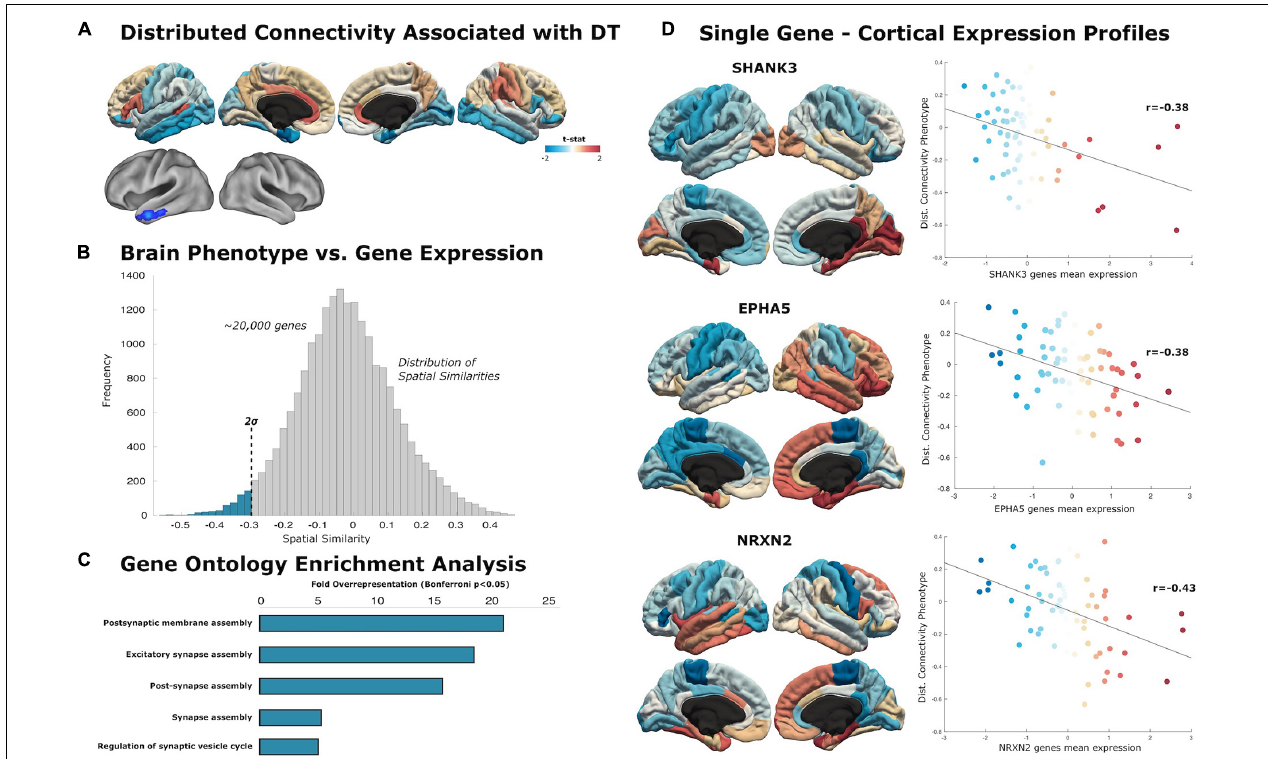
FIGURE 3 | Distributed connectivity maps. (A) Cortical surfaces display t -statistic of the regression between the distributed connectivity and DT. Above, data is projected to 68 cortical regions of the Desikan–Killiany atlas to capture mean connectivity across these regions. Below, cortical projection of the t-statistic at the voxel-level, showing regions that survive to multiple comparison with cluster wise Monte Carlo simulation. (B) The similarity distribution represents the results of topographical similarity analysis between the distributed connectivity network and the brain transcriptome maps ( ∼ 20,000 protein-coding genes). Genes which have a highly negative similarity score (below dotted line at 2 SDs) are inversely related to our distributed connectivity map, meaning they are highly expressed in regions with low connectivity. (C) Gene Ontology enrichment analysis reveals this subset of 516 genes exhibit overrepresented functionalities in key domains of post-synaptic assembly (FE > 15; statistically significant FDR-corrected q < 0.05). (D) Scatterplots show the spatial similarity relationship throughout brain regions between independent expression of three genes (SHANK3, EPHA5, and NRXN2) and the distributed connectivity map (linear fit represented with a black